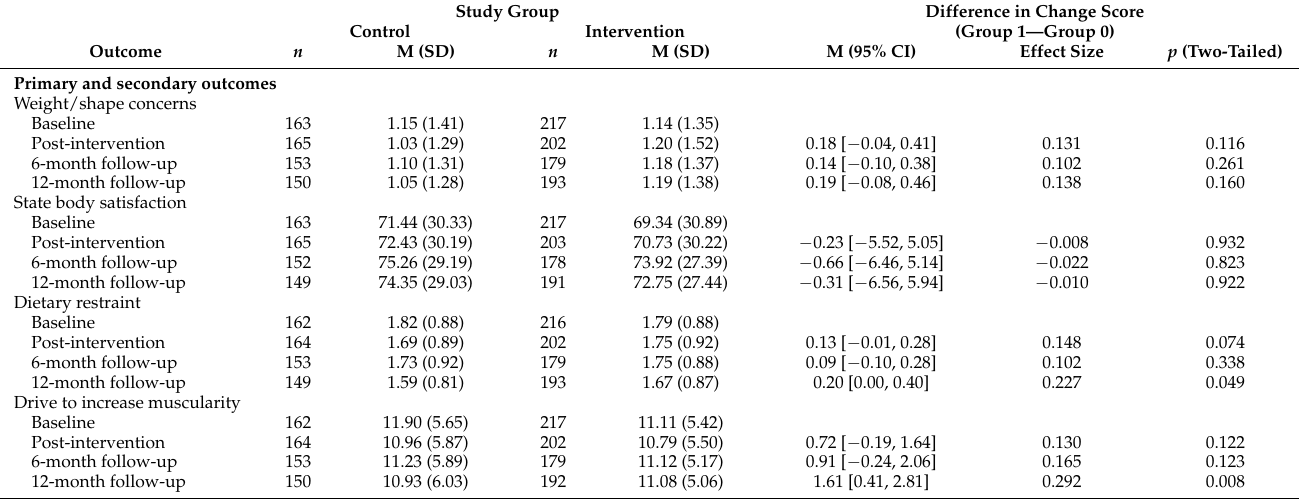
Table 5. Mean changes in study variables at post-intervention and 6- and 12-month follow-up for boys only. Study Group Difference in Change Score Control Intervention (Group 1—Group 0)